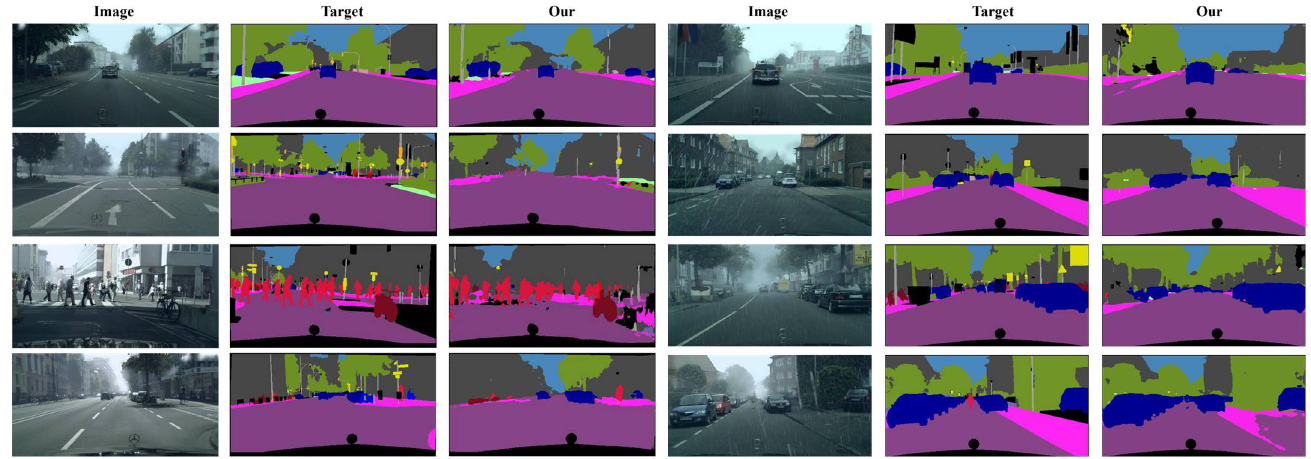
Figure 20. Visualization results on Cityscapes with rain and fog (including complex class).